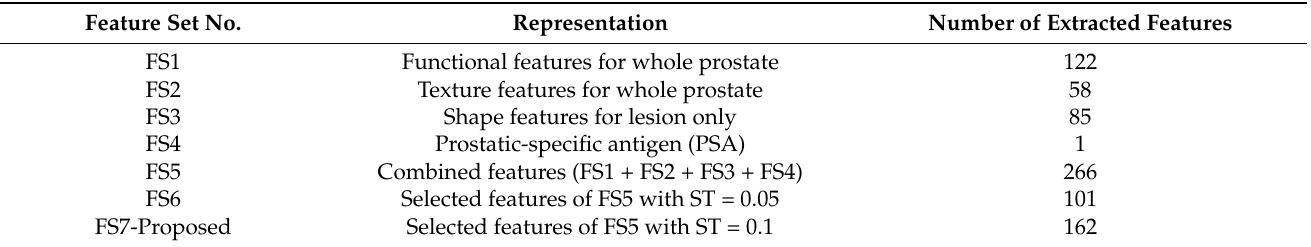
Table 2. Details of the extracted feature sets. Let ST denote the significance threshold. Feature Set No. Representation Number of Extracted